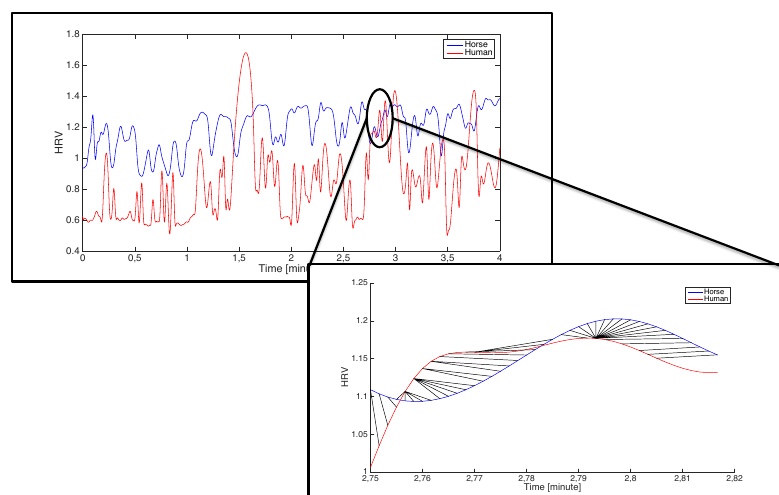
Figure 4. Example of both human and equine heart rate variability (HRV) signals. Within the smaller portion of signal, it is shown how the warping-paths are defined.